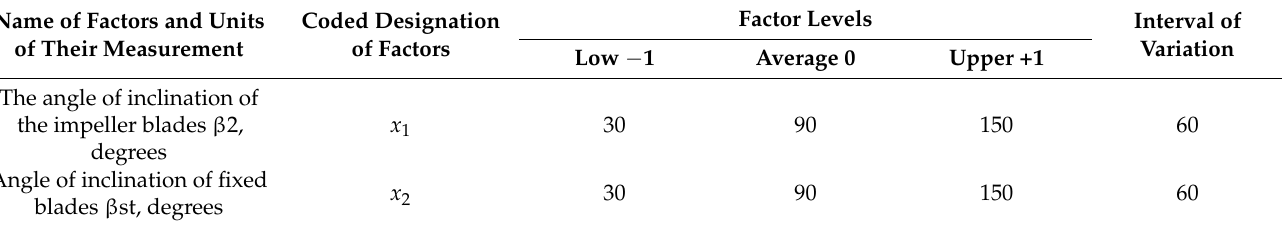
Table 3. The plan of the experiment to determine the optimal parameters.